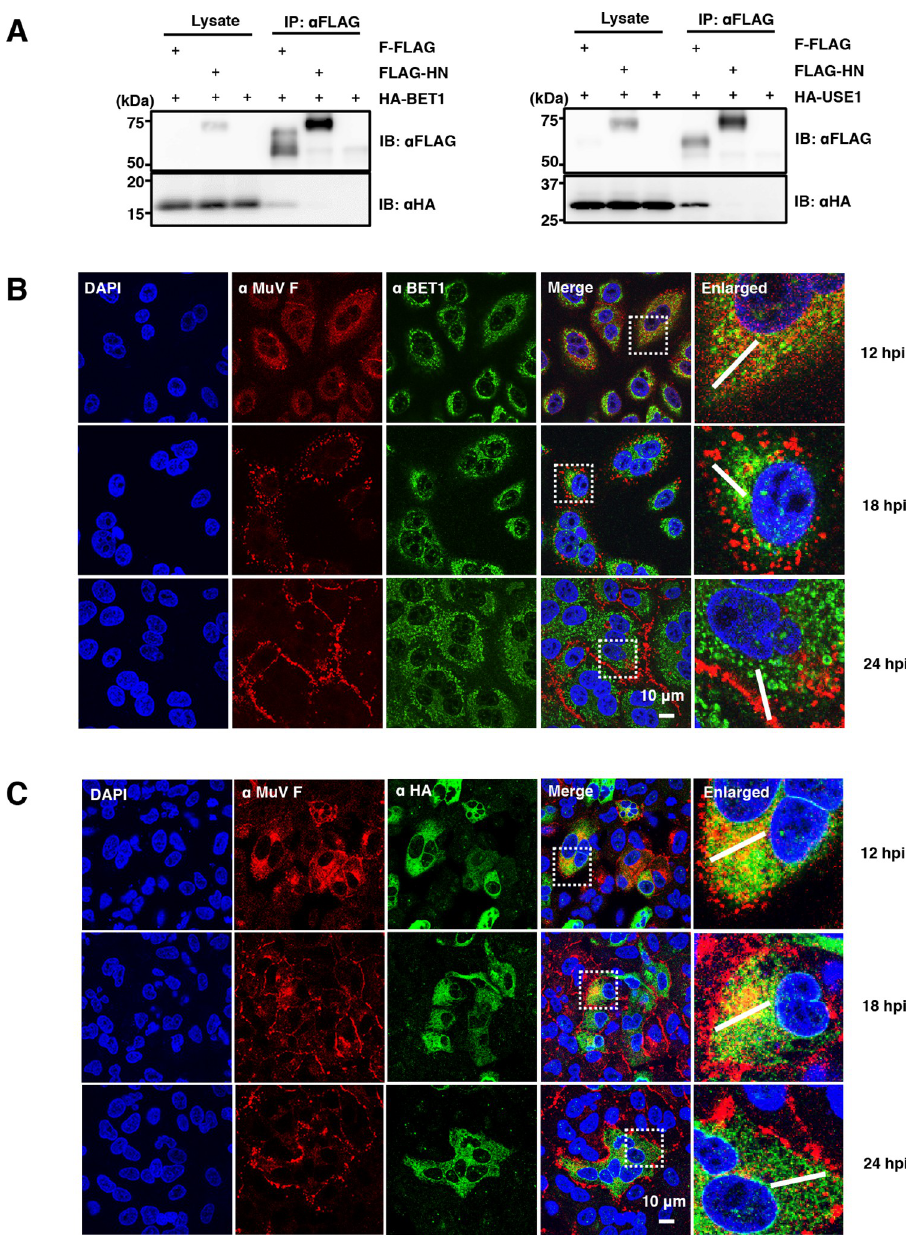
Fig 4. Interaction of BET1 and USE1 with the MuV F protein in the ER. ( A) Immunoprecipitation assay showing the interaction of F-FLAG or FLAG-HN proteins with HA-BET1 (left) or HA-USE1 (right) in 293T cells. (B) Immunofluorescence assay showing the localization of MuV F protein and BET1 in A549 cells. (C) Immunofluorescence assay showing the localization of MuV F protein and USE1 in A549 cells expressing HA-USE1. The experiments were performed at least three times, and representative data are